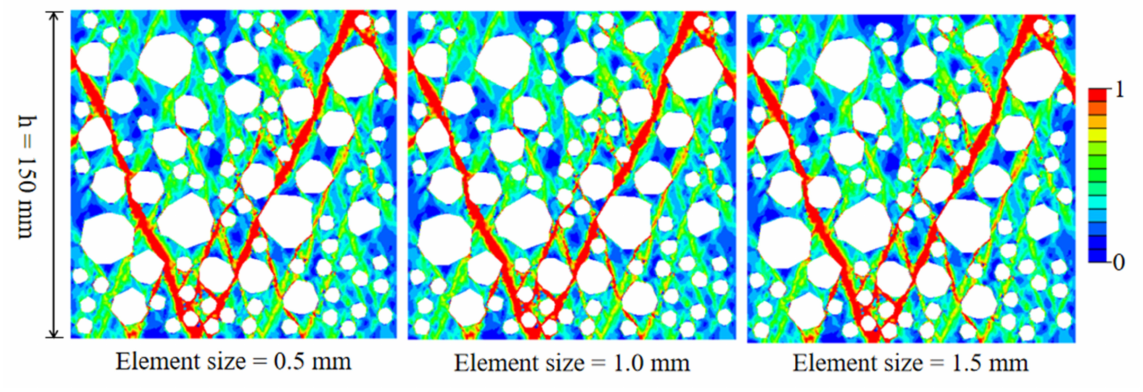
Figure 13. The effect of the mesh size on the failure mode of RAC under uniaxial